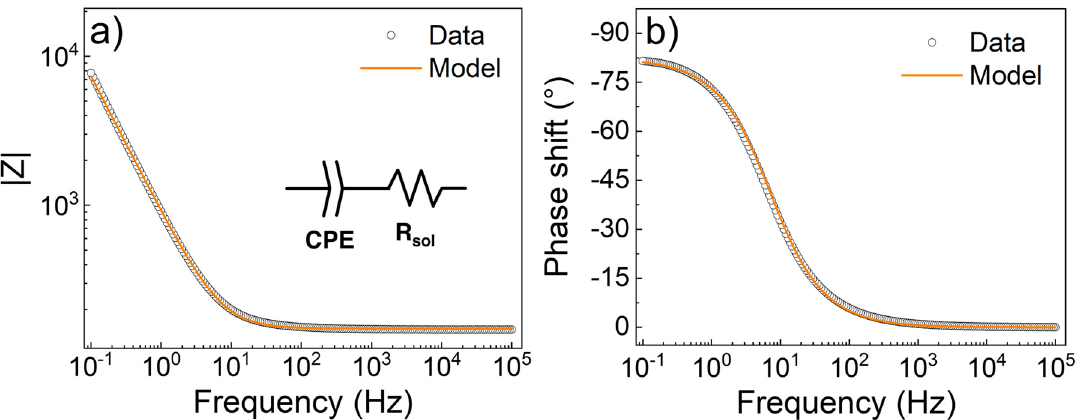
Figure 8. Electrochemical impedance spectroscopy data (black circle) and model (orange line) for the interface IrO 2 /electrolyte. ( a ) Module and ( b ) phase shift of the impedance as function of the frequency. The inset in ( a ) shows the equivalent circuit used for the modeling, i.e., a constant phase element (CPE) for the double layer, in series, with a resistor (R sol ) for the solution bulk.